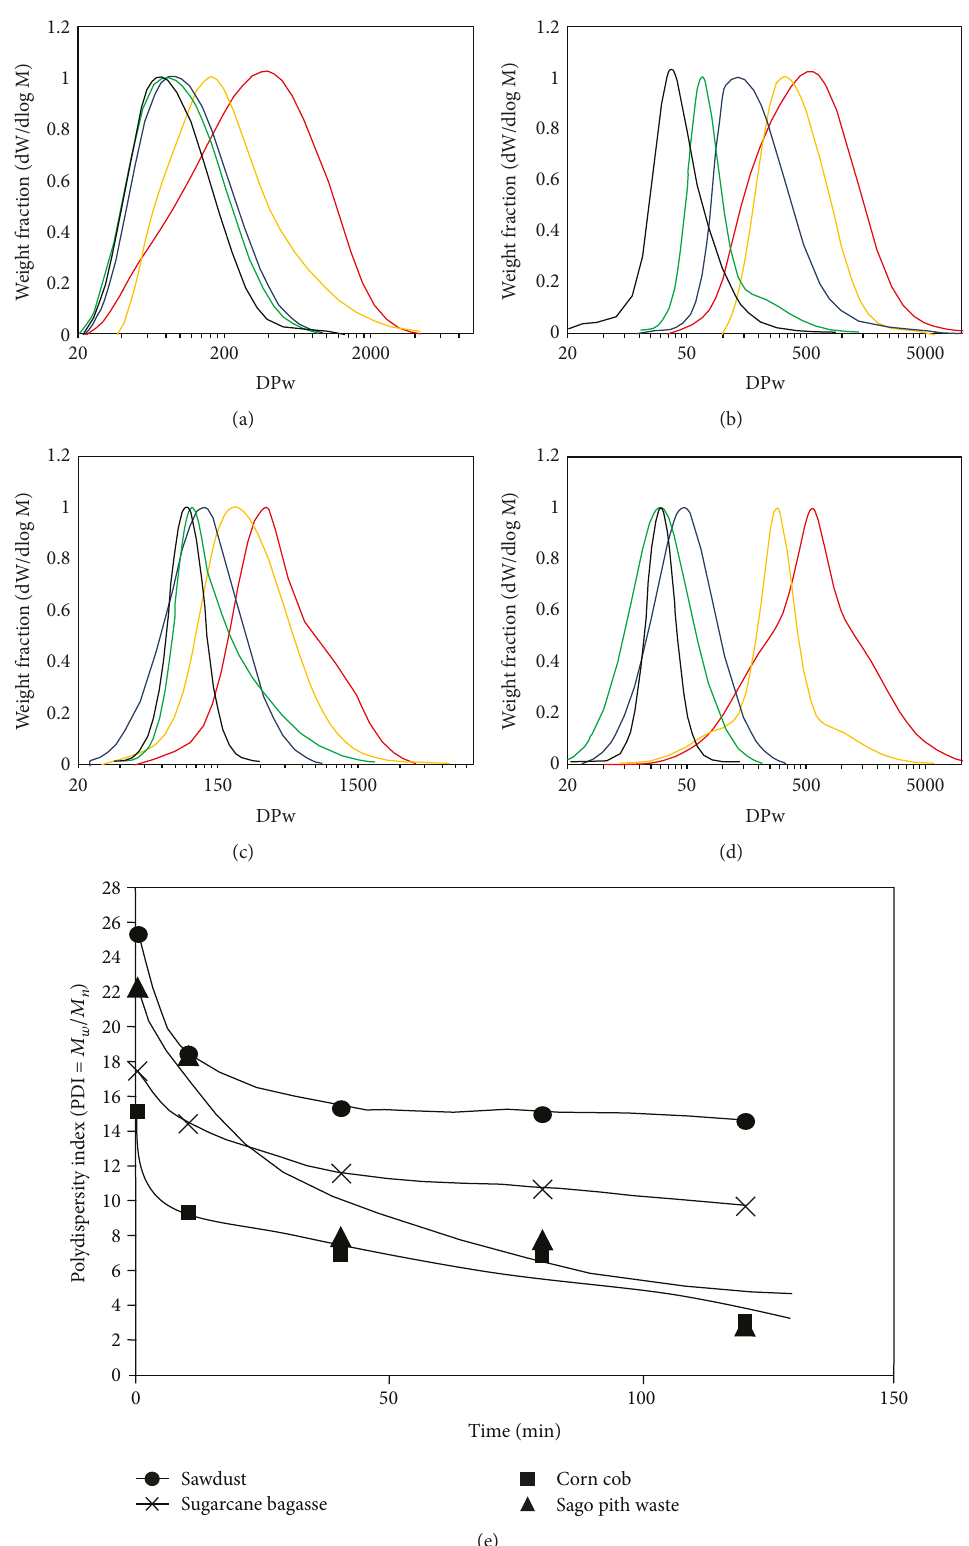
Figure 5: DPw distribution of various LBW of the cello-oligomers obtained from cellulose fi bres at di ff erent reaction times: (a) sawdust, (b) sugarcane bagasse, (c) corn cob, and (d) sago pith wastes and (e) polydispersity index (PDI). (Red line: original cellulose fi bres, yellow line: 10min, blue line: 40 min, green line: 80 min, and black line: